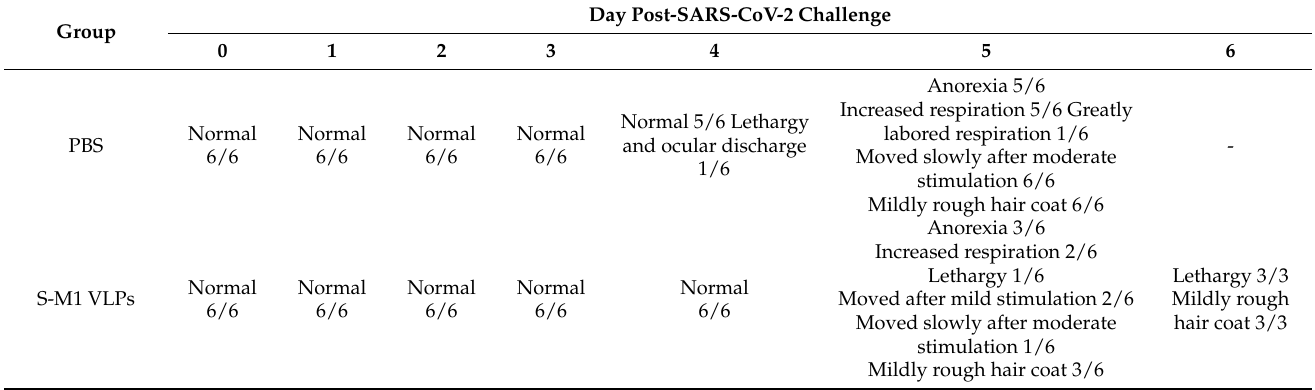
Table 1. Clinical signs